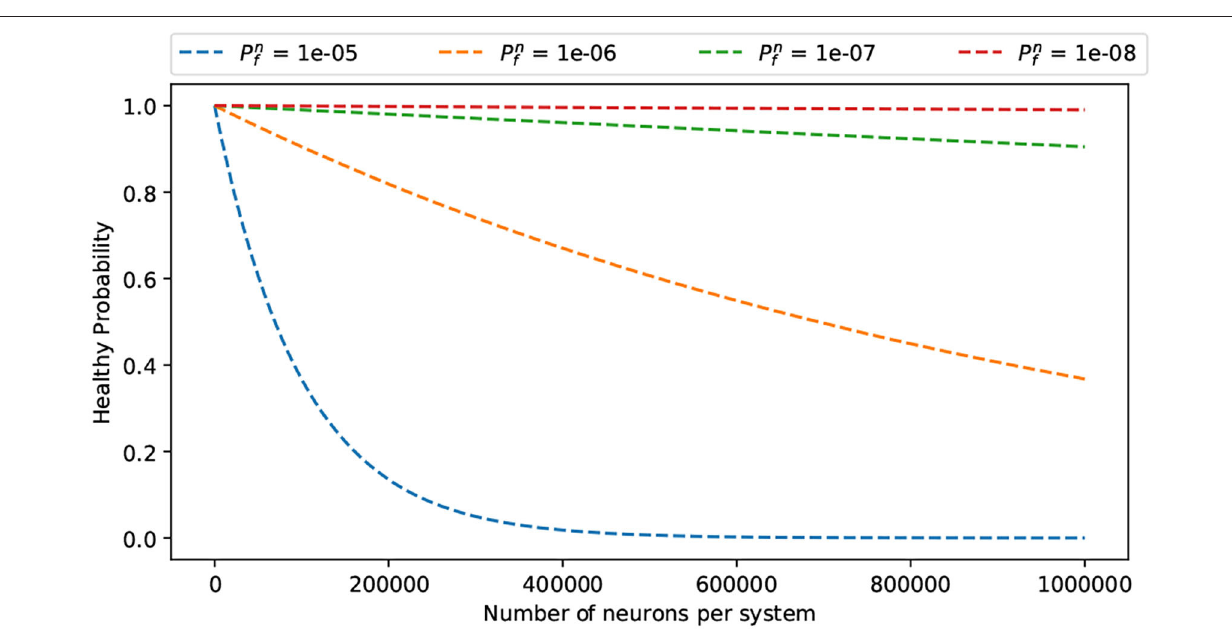
FIGURE 10 | Reliability of large scale